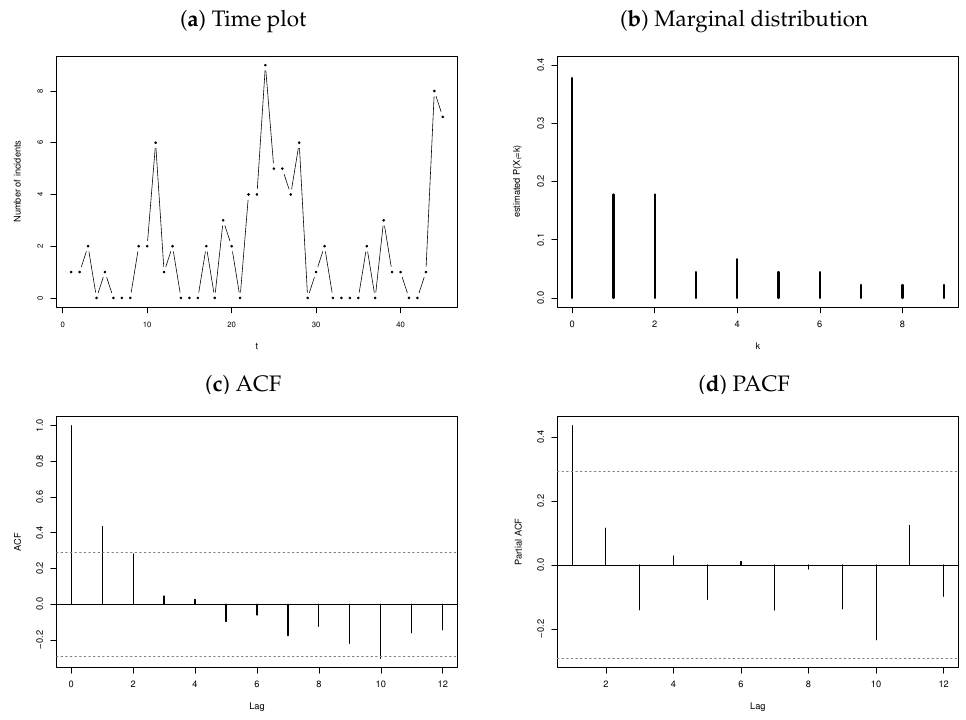
Figure 10. Time plot, observed marginal distribution, ACF, and PACF for the terrorism